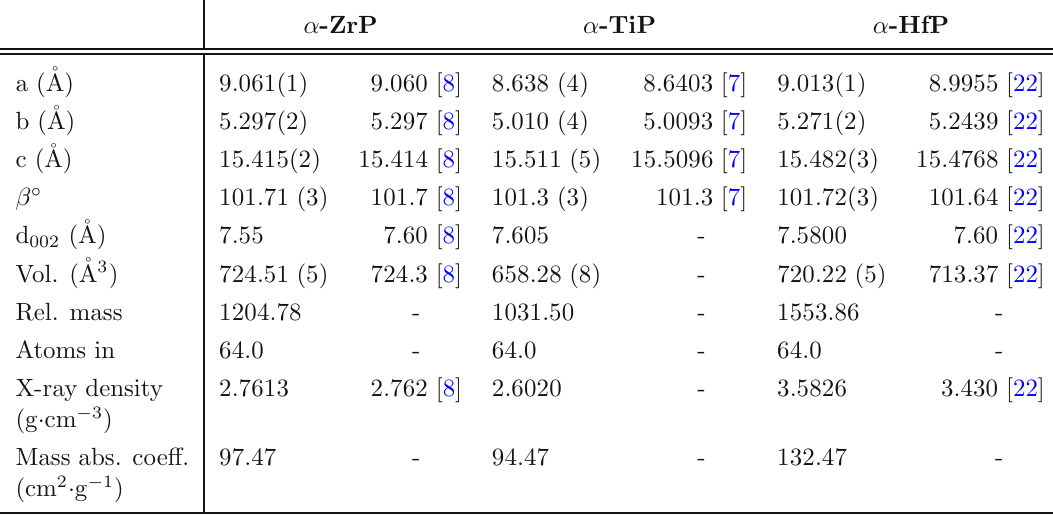
Fig. 1 The difference plot of α -hafnium phosphate (measured and calculated). Table 4 Unit cell parameters of metal(IV) phosphates. α